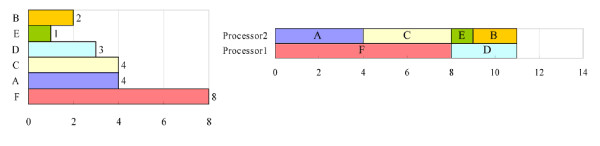
The result of moving long tasks forward in the processing order list. The long tasks are moved forward in the processing order list in Figure 2, yielding the new processing order list. The overall processing time for a two-processor computer is 11 units, which equals the optimal processing time.